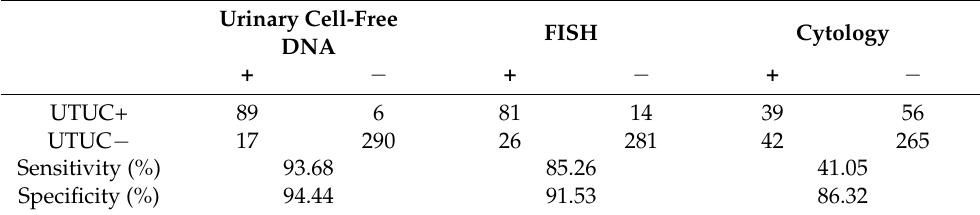
Table 4. Effectiveness of the novel model, cytology and FISH in the diagnosis of